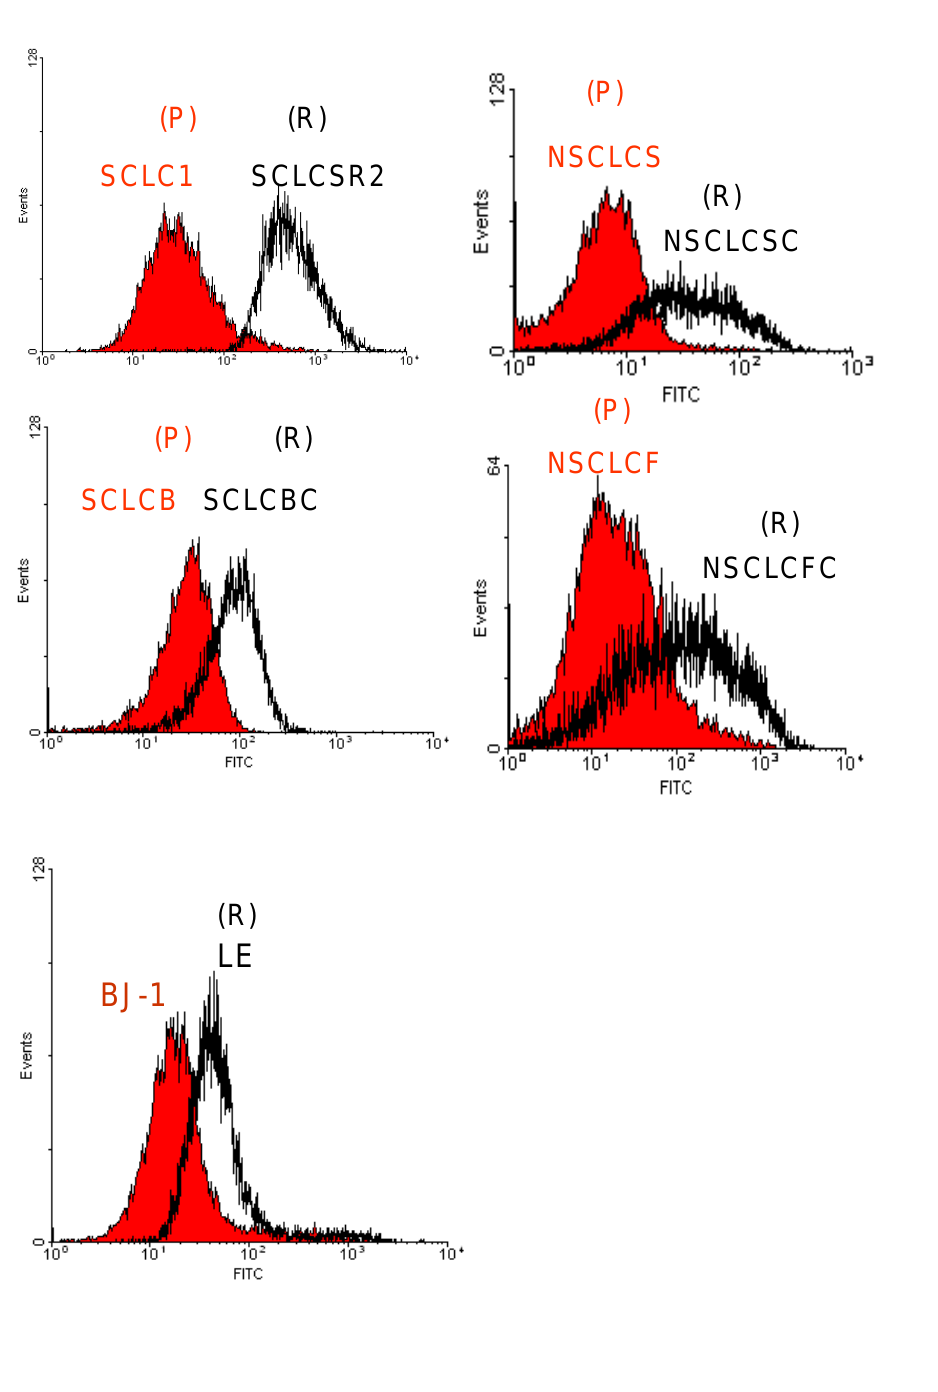
comparison with the primary cisplatin-resistant cells. Our data strongly indicate that cisplatin resistant cell lines possess intrinsically high basal ROS levels than their parental counterparts and normal cells. Figure 1. Flow cytometry analysis of ROS in various lung cancer cell lines detected by DCF-DA probe. The cisplatin resistant variants (R) are shown to possess higher basal levels of ROS when compared to parental cells counterpart (P). Each histogram is representative of three experiments (average P < 0.03, parental vs. resistant). BJ-1 was used as